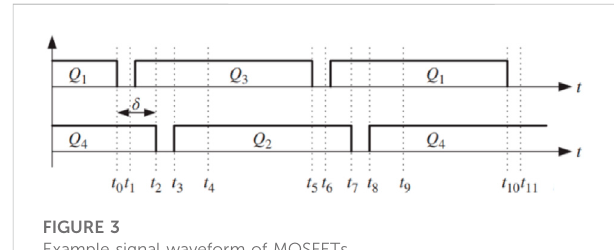
FIGURE 3 Example signal waveform of